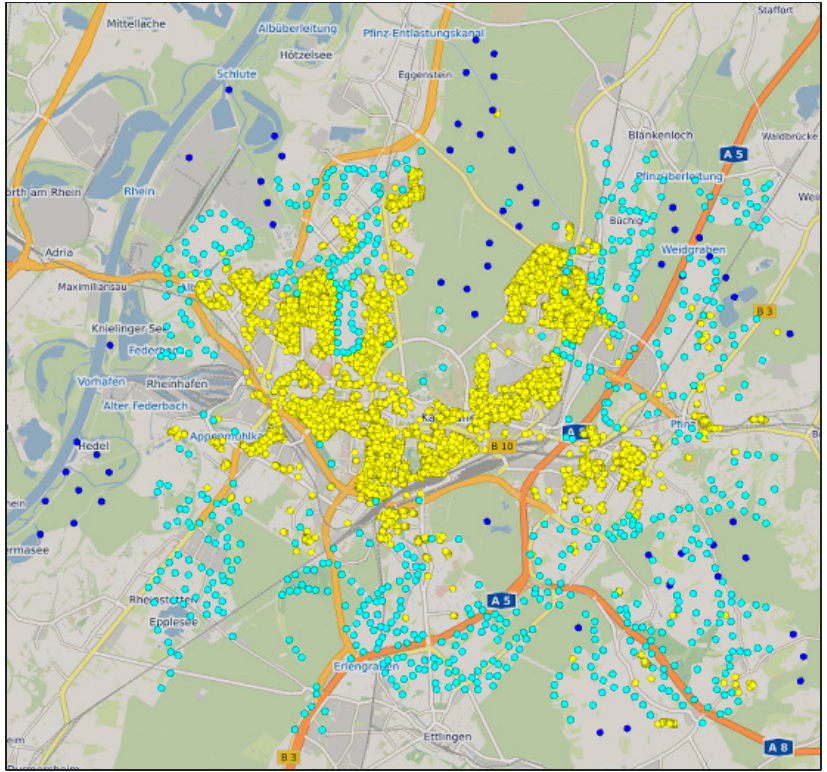
Figure 2. The entity locations for the agent-based simulation. Blue indicates potential wind turbines, cyan indicates potential photovoltaic plants, and yellow indicates survey participants.